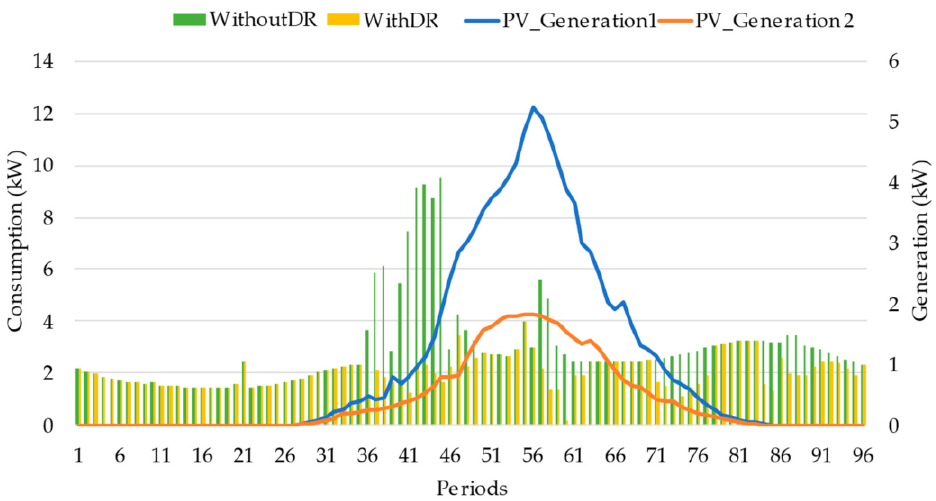
Figure 9. Prosumer ID2 consumption and generation